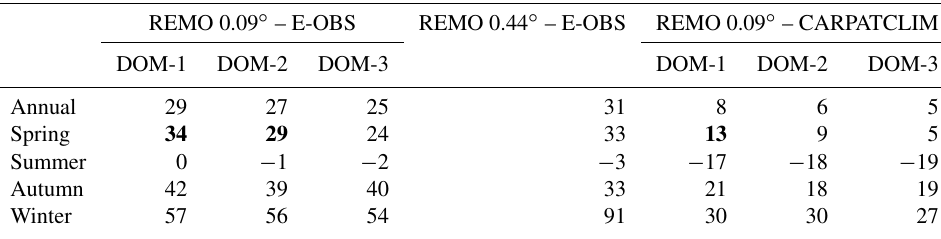
Table 3. Annual and seasonal relative precipitation bias (%) between the three model simulations and REMO_0.44 compared to the E-OBS (first four columns) and between the 10km model simulations and CarpatClim-HU data (last three columns). Precipitation data above lakes and rivers is not taken into account in the spatial averages of REMO. In case of differences in mean bias between DOM-1 or DOM-2 and DOM-3 reach 5%, it is indicated with